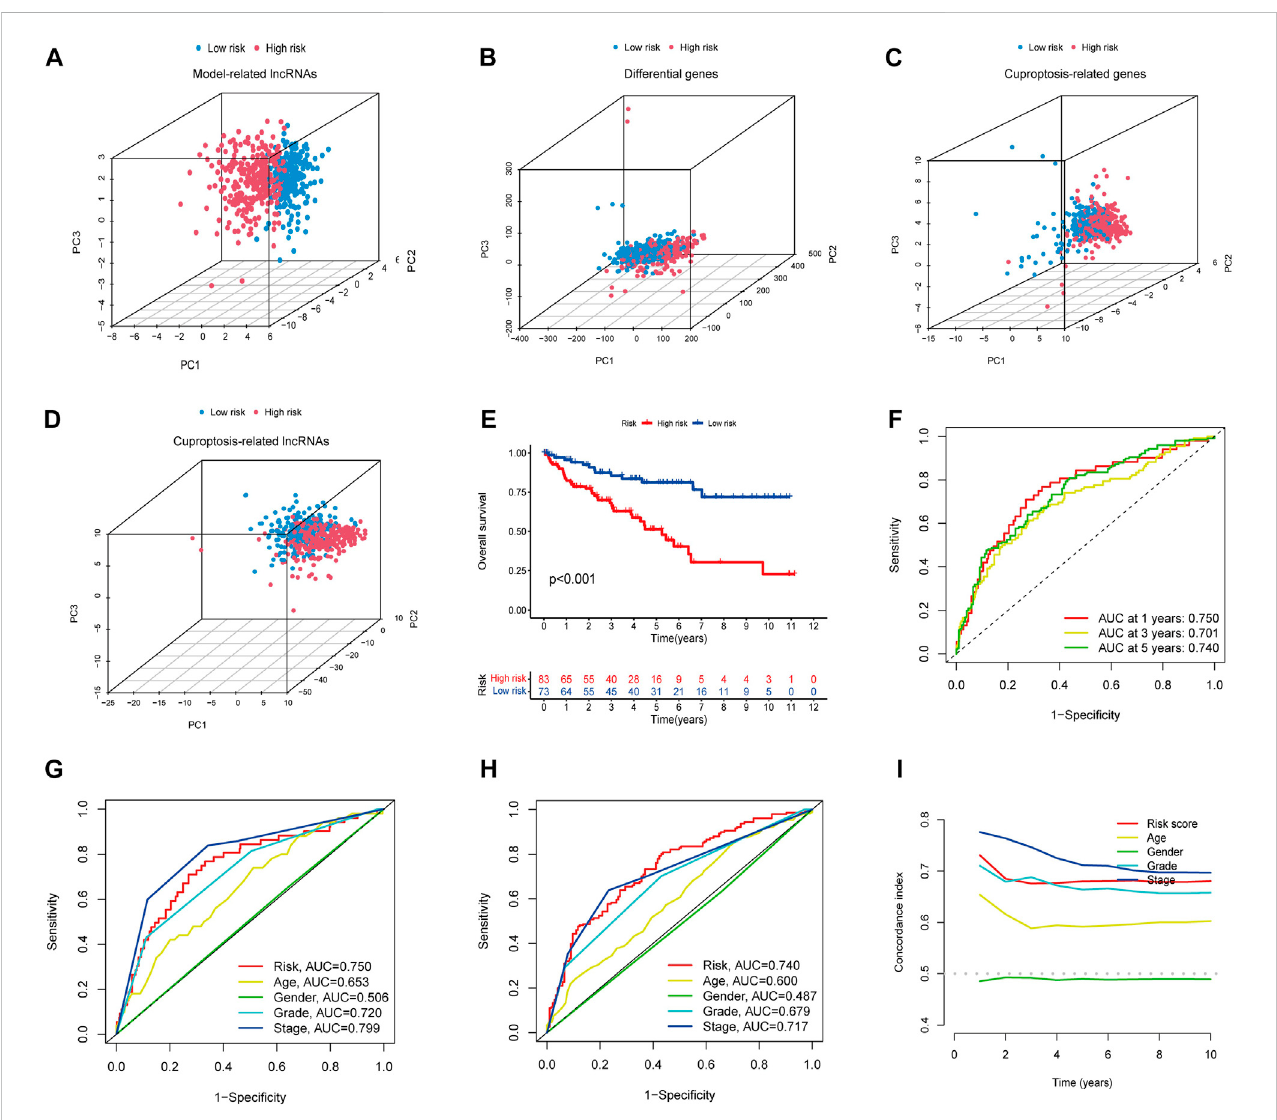
FIGURE 3 (A – D) PCA analysis of model lncRNAs, PCA analysis of cuproptosis-related lncRNAs, PCA analysis of cuproptosis-related genes, and PCA analysis of all genes,respectively. (E) Kaplan-Meiercurvesofhighandlow-riskgroupinTCGA. (F) ROCcurvesfor1,3,and5-yearprognosticcharacteristicsusingCGGArisk score. (G,H) TheROCcurvesinTCGAdataset.Thelargertheareaunderthecurve,thegreatertheaccuracyofpredictingthesurvivaltimeofpatientsthrough the model. (I) The C-index curve of risk score was used to assess the model. The ordinate is that the C-index score is the better the